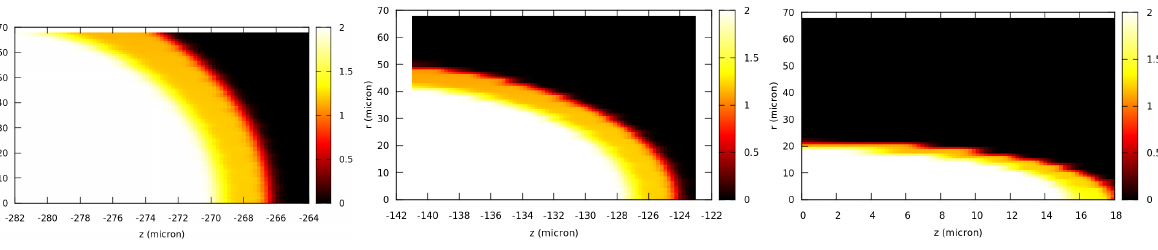
Figure 10. Ionisation map of He with the laser pulse at two Rayleigh ranges before the best focus ( left ), at one Rayleigh range ( centre ) and at the best focus position. The graph shows that full ionisation in He occurs well before the pulse enters the focal region.